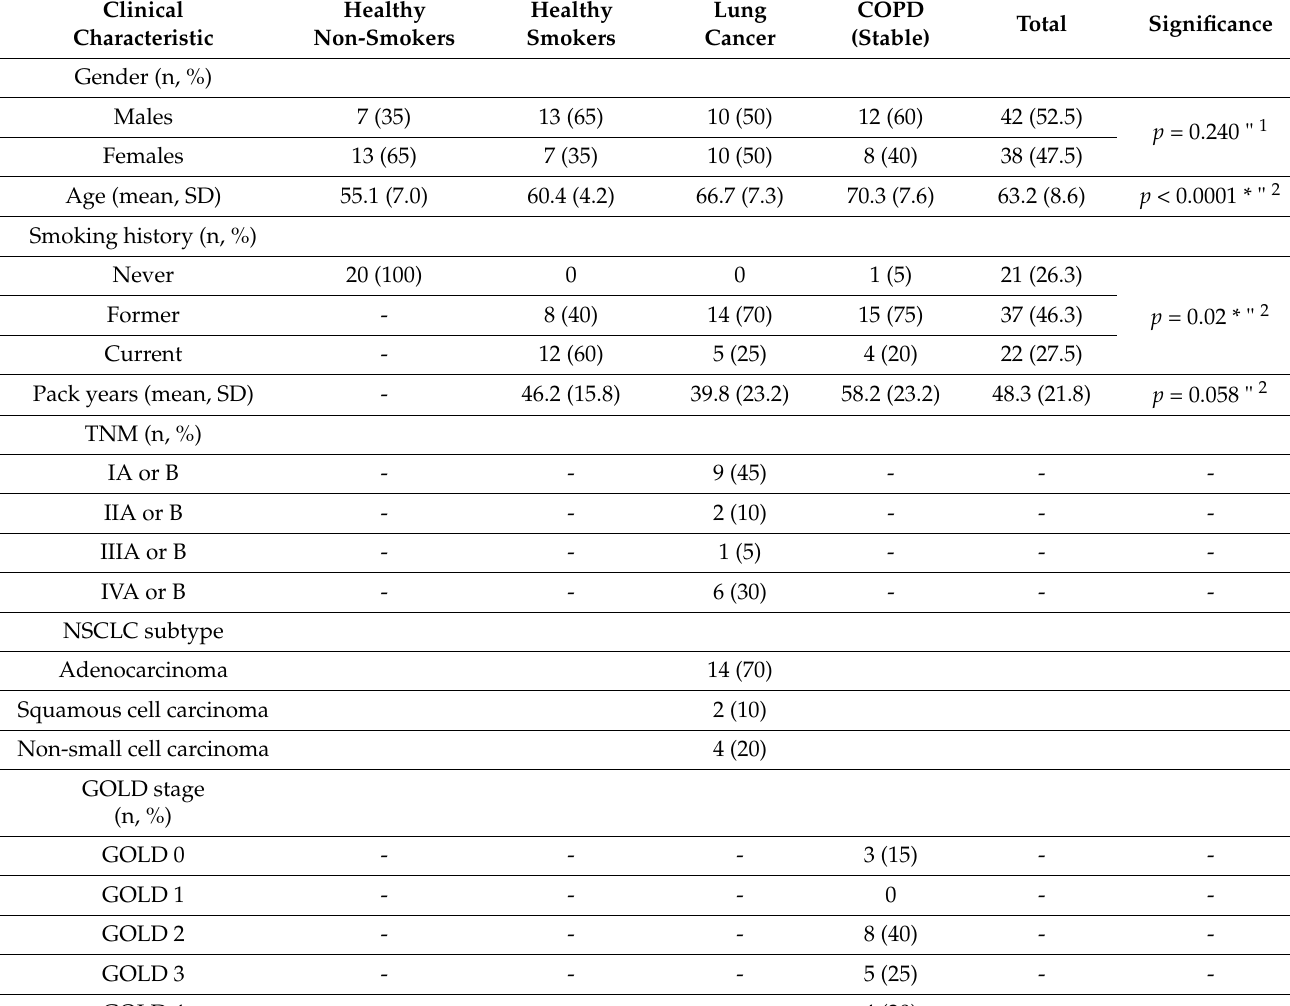
Table 1. Clinical characteristics of healthy non-smokers (n = 20), healthy smokers (n = 20), lung cancer (n = 20) and COPD (stable, n = 20)